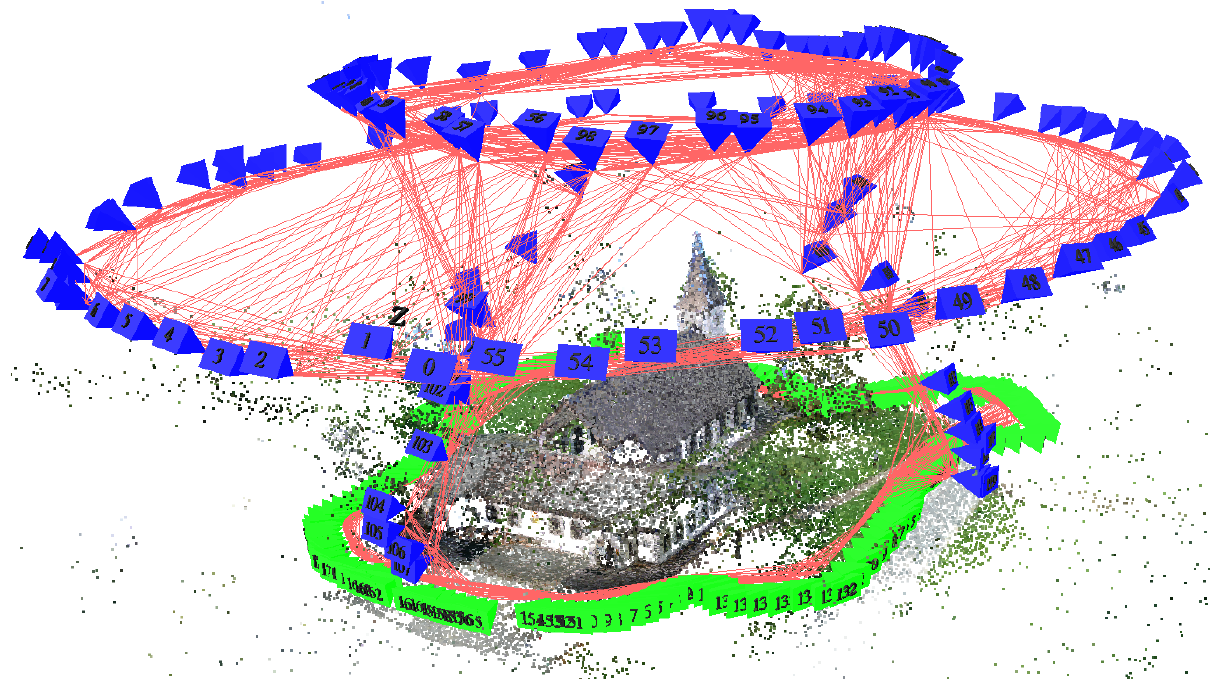
Figure 4: Orientation of 340 images taken from the ground and an Unmanned Aerial System (UAS) – pyramids represent cameras and links between cameras symbolize the existence of at least ten common points